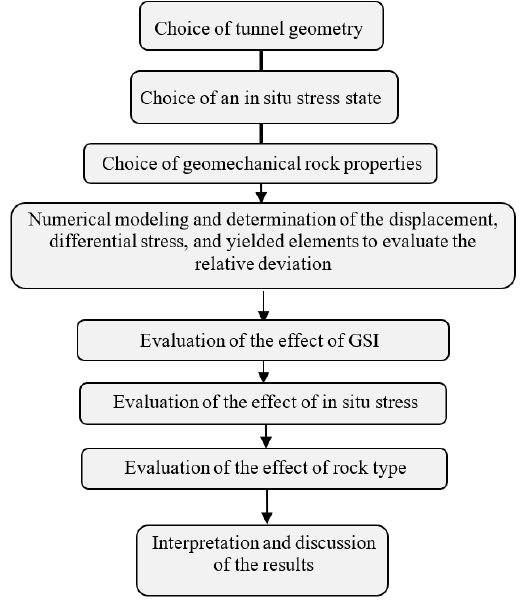
Figure 3. Methodology to compare the equivalent Mohr-Coulomb (EMC) and generalized Hoek- Brown (GHB) criteria.